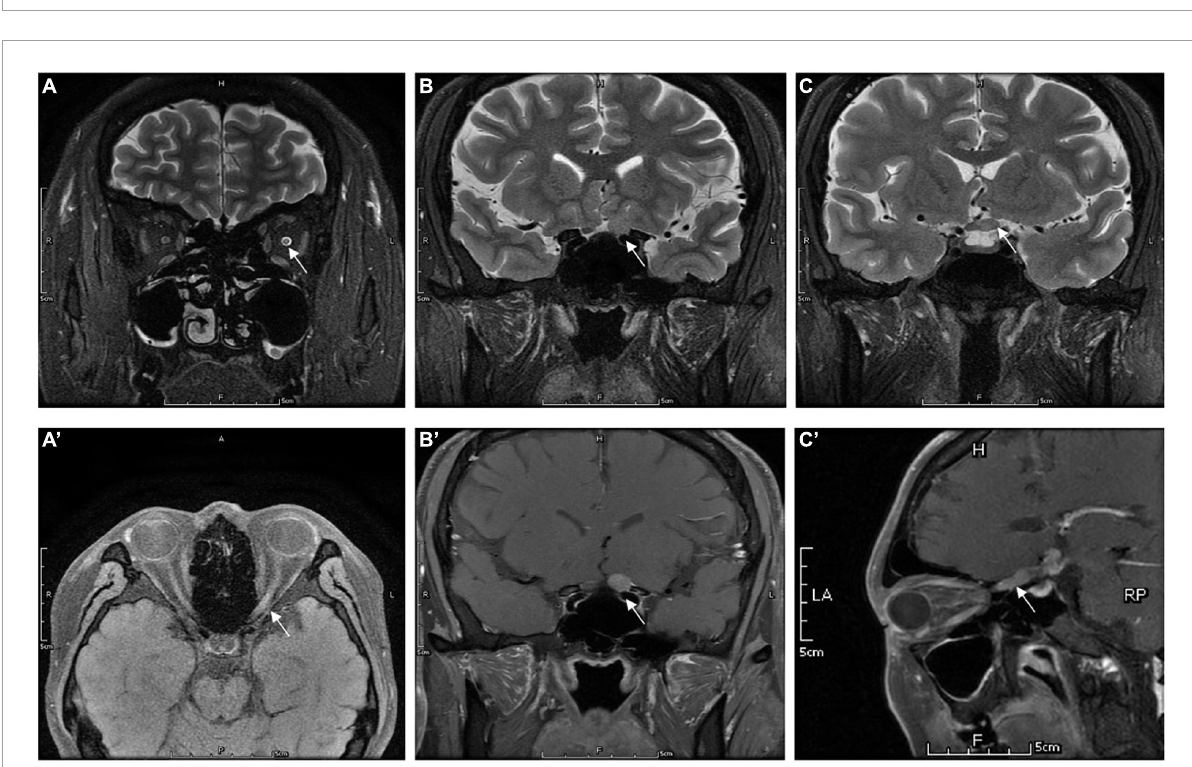
FIGURE3 Orbital MRI images in patients who were diagnosed with IGM (case 7): panels (A) (axial), and (B,C) (coronal) showed the hypersignal of the optic nerve (the white arrow) extends to optic chiasm in T2WI. Panels (A (cid:48) ) (axial), (B (cid:48) ) (coronal), and (C (cid:48) ) (sagittal) showed the enhancement of left ON (the white arrow) in gadolinium-enhanced